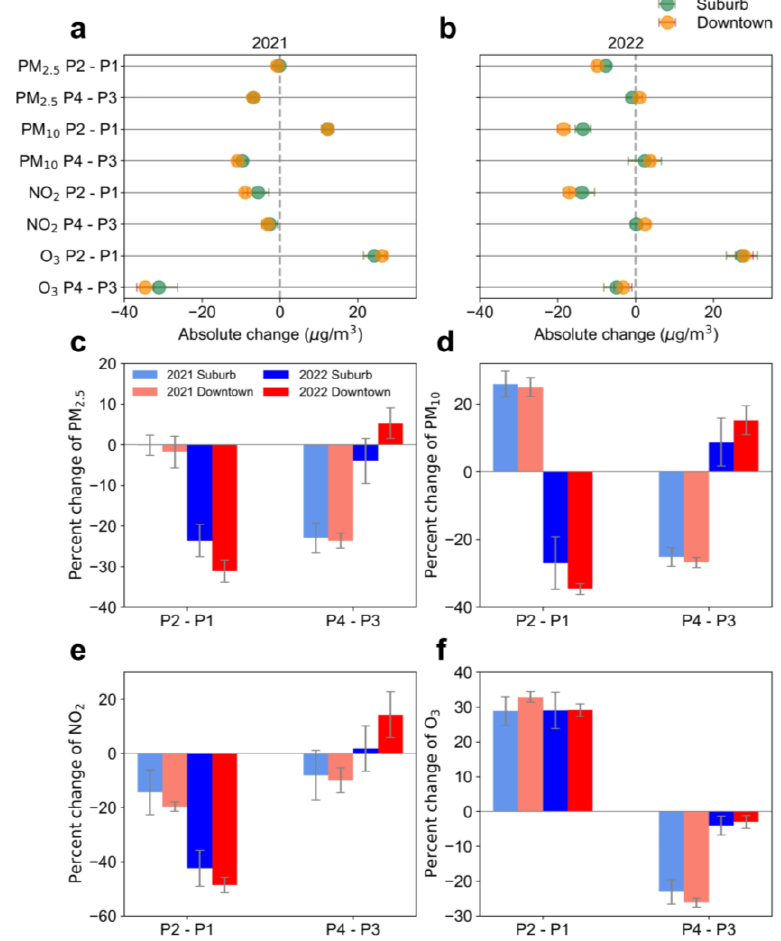
Figure 9. Interperiod absolute change ( a , b ) and relative change ( c – f ) in different ground-based air pollutant concentrations during 2021 and 2022 from P1 to P4 in suburbs and downtown with 95% confidence intervals (error bars).